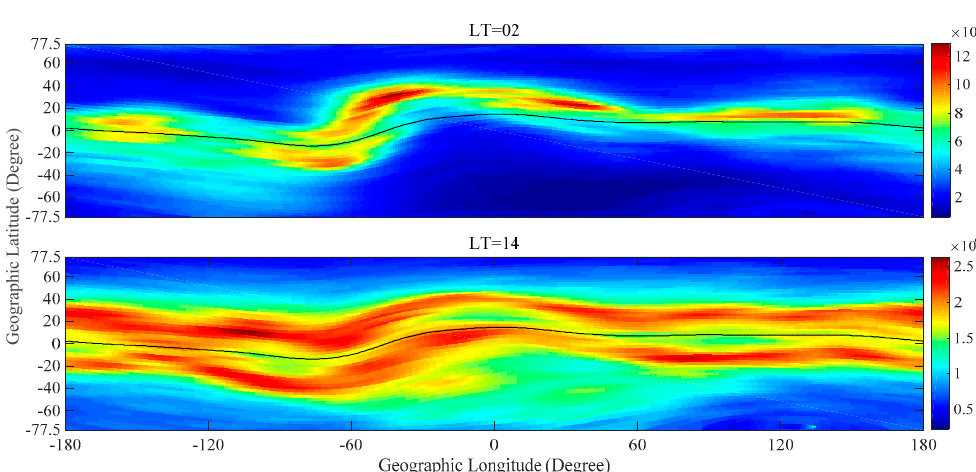
Figure 14. Same as Figure 10, but for NPPDM under high solar activity.